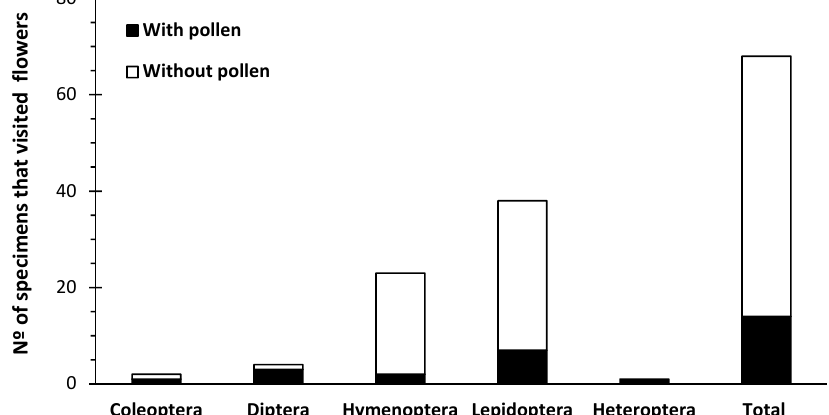
Figure 2. Representativeness of the insects (orders) carrying pollen or not that visited Limonium inflorescences.